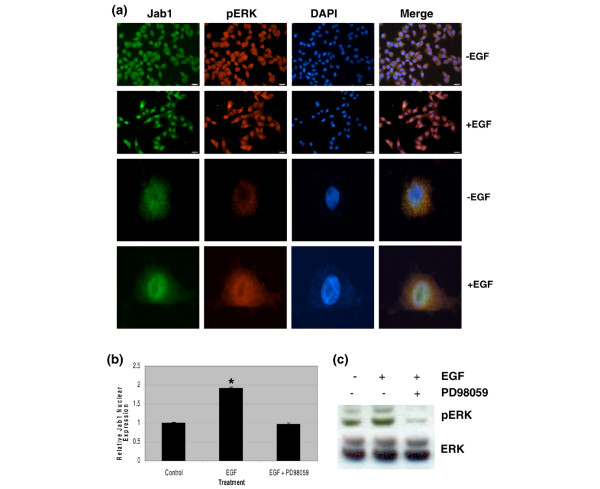
Epidermal growth factor (EGF) stimulation of Jab1 nuclear translocation is dependent on pERK and is associated with pERK in the nucleus in MDA-MB-231 cells. (a) Enhanced colocalization of Jab1 and pERK in the nucleus following EGF treatment. (b) Quantitative image analysis of nuclear Jab1 expression in cells treated with EGF and in cells treated with EGF and the ERK inhibitor, PD98059. Bars represent mean ± standard deviation. Statistical analysis was by t test (*P < 0.01). (c) Increased pERK expression following EGF treatment. The addition of ERK inhibitor, PD98059, eliminated this effect. DAPI, 4'-6-diamidino-2-phenylindole; ERK, extracellular signal-regulated kinase; Jab1, c-Jun activation domain-binding protein-1; pERK, phosphorylated extracellular signal-regulated kinase.